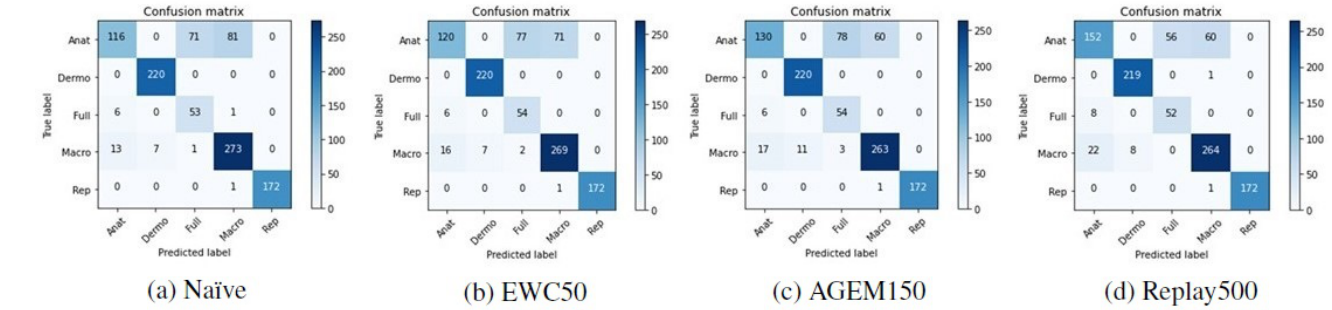
Figure 6. Confusion matrices of Task A test images after the training of Task B with the MobileNetV2 model.